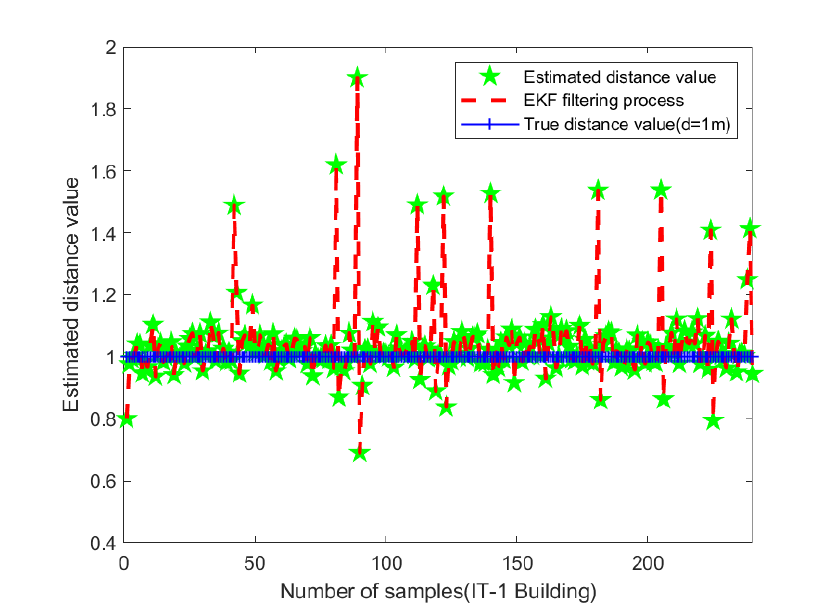
Figure 16. The comparison of the distance value and the real value after the extended Kalman filter